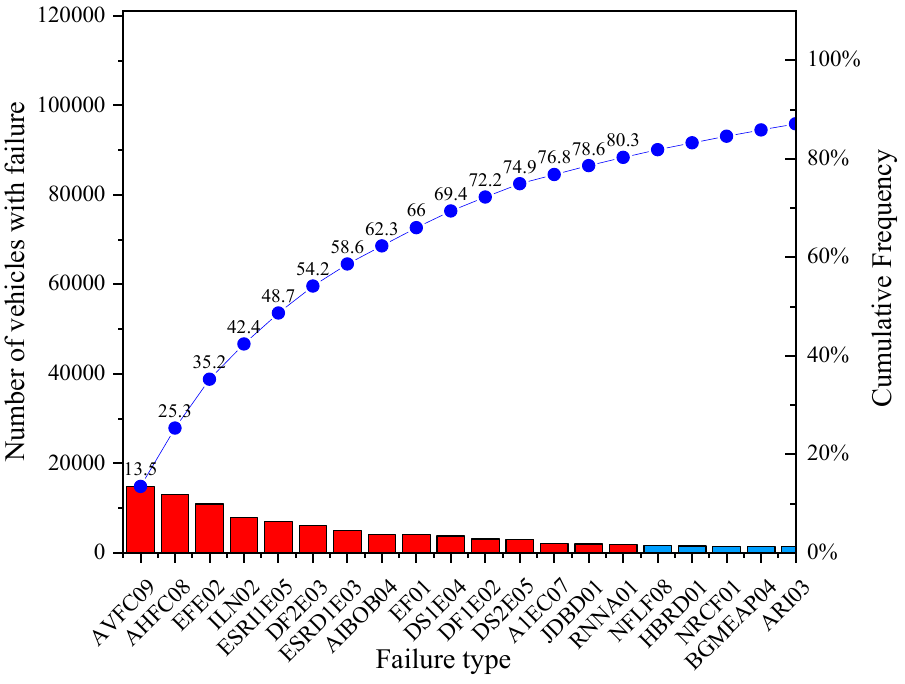
Figure 6. VTI representative failures for subcategory N1.